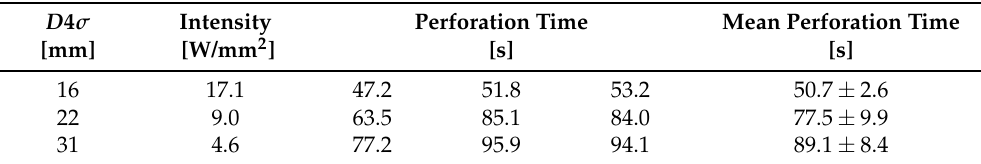
Table 1. Perforation times for three repetitions of laser penetration with three different spot diameters D 4 σ . The intensity is the calculated mean value within the 86%